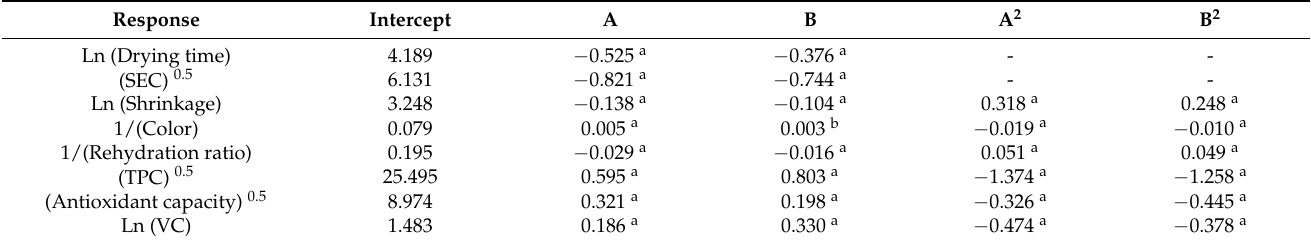
Table 5. Coefficients of the model fitted to the regression equation of response variables (A: air temperature and B: microwave